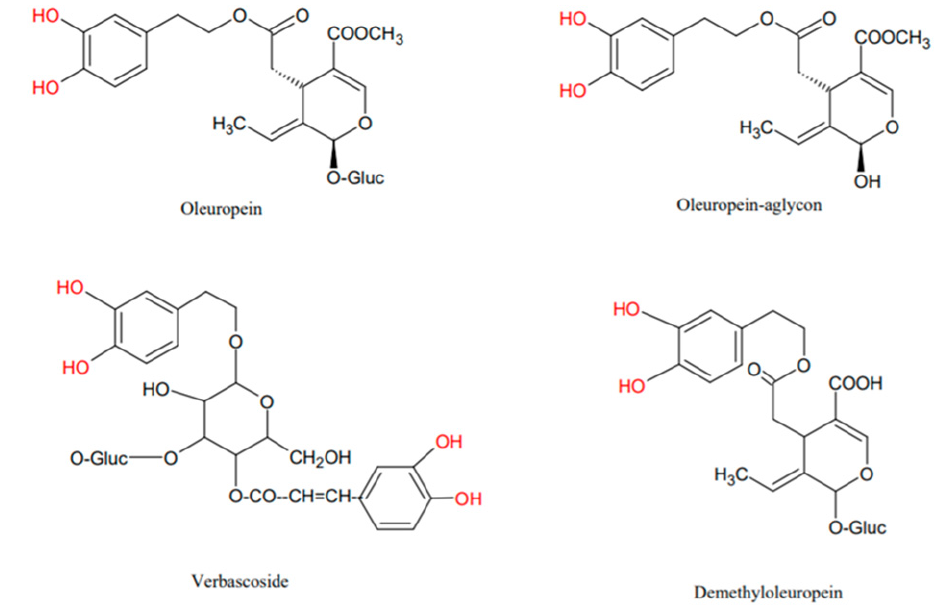
Figure 12. Chemical structures of ortho-diphenolic compounds highlighting the ortho-diphenolic structures.